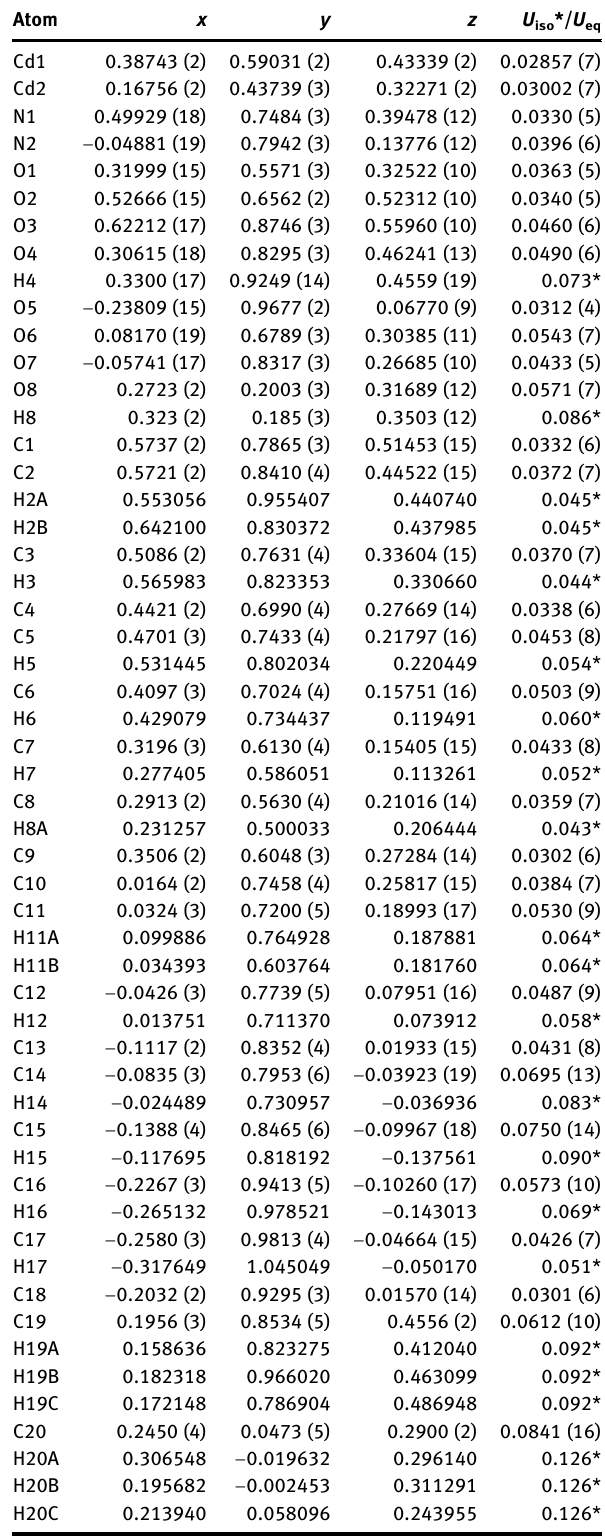
Table  : Fractional atomic coordinates and isotropic or equivalent isotropic displacement parameters (Å 